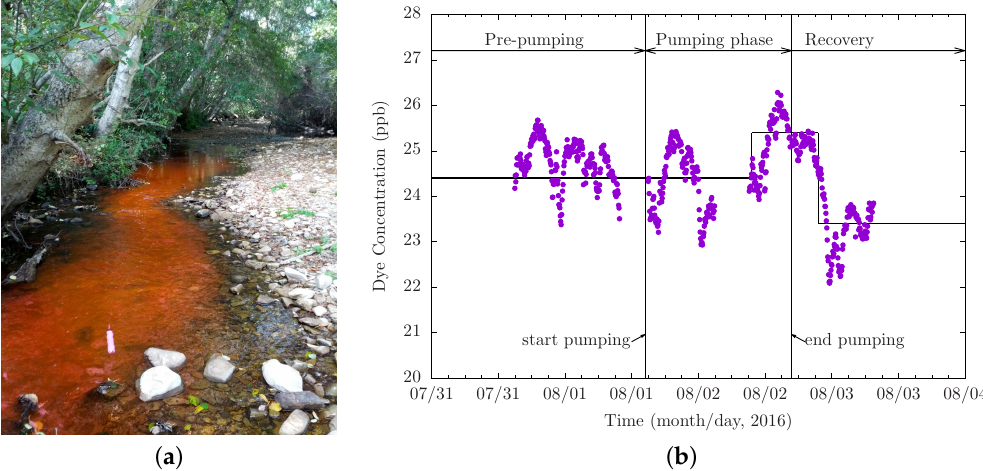
Figure 8. ( a ) Rhodamine WT dye in Scotts Creek and ( b ) measured dye concentration (ppb) in the creek during the pre-pumping, pumping, and recovery phases of the AG3 well pumping test. Average concentration indicated with the piecewise solid